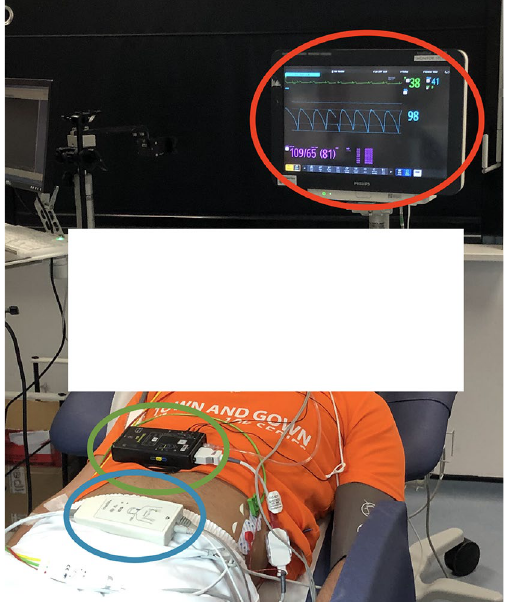
Figure 8. Equipment set up in our clinical study. The Philips patient monitor is circled in red, the Stowood device is circled in green and the CardioScreen device is circled in blue. Consent was obtained from the participant to use the image for